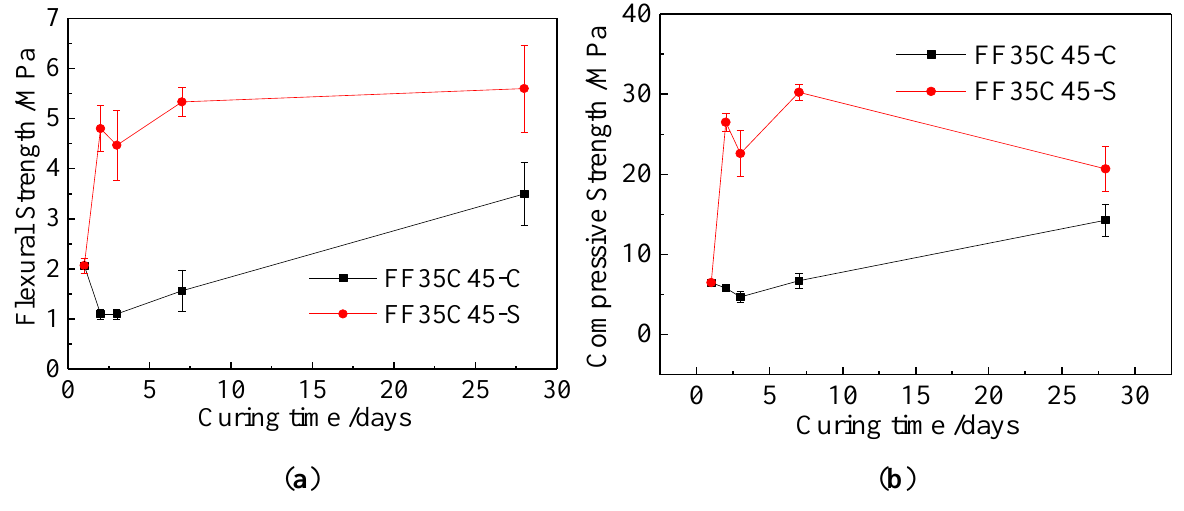
Figure 3. Effect of curing conditions on strength of Class F fly ash mixed with Ca(OH) geopolymer mortar. ( a ) Flexural strength; and ( b ) compressive